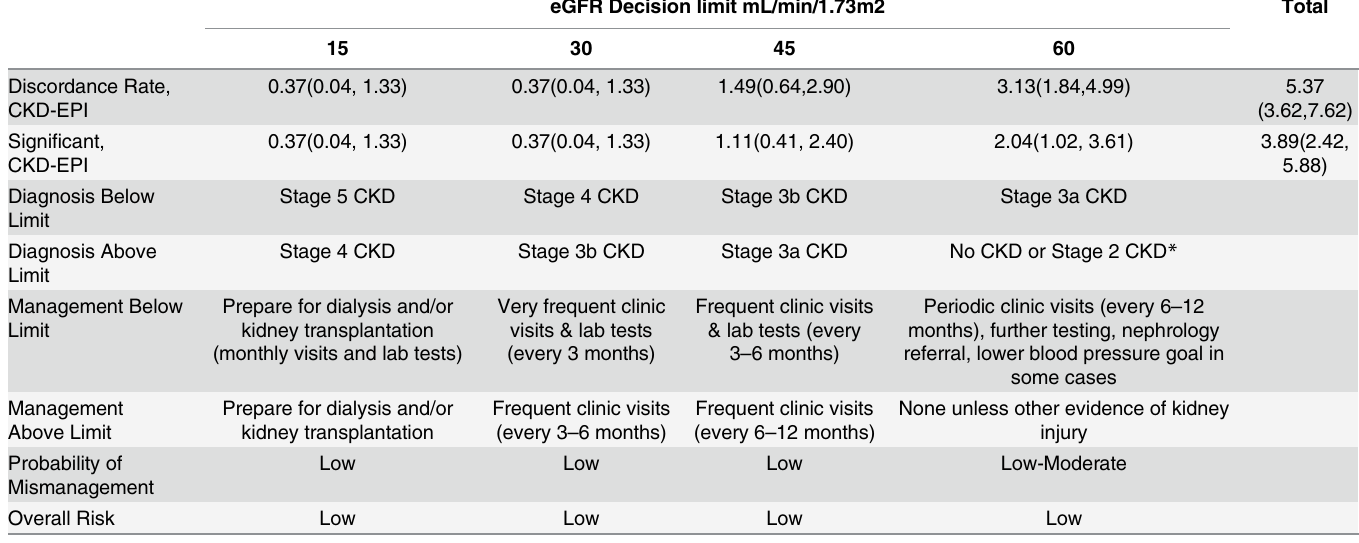
Table 4. Risk assessment for Jaffe